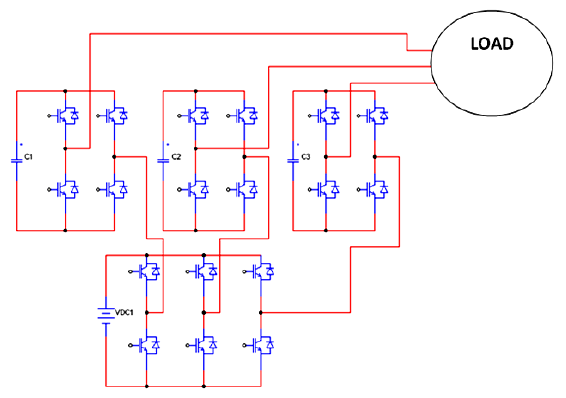
Figure 13. Circuit diagram for three-phase Figure 13